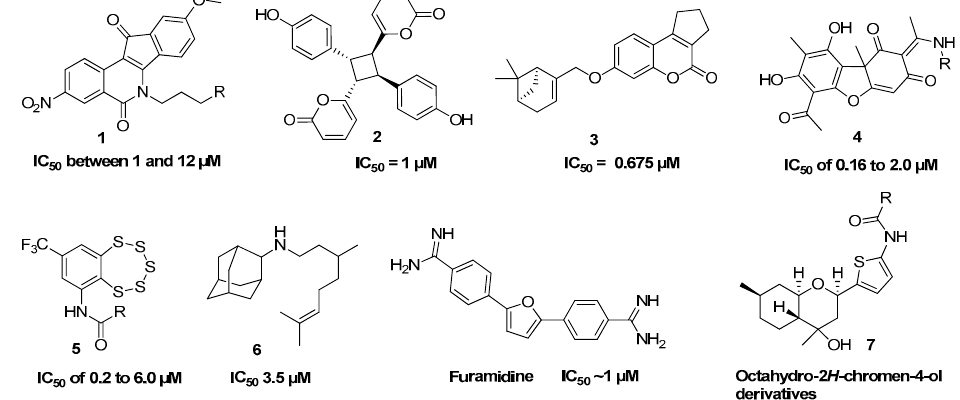
Figure 1. Structures of reported Tdp1 inhibitors 1 – 6 , commercial Tdp1 inhibitor Furamidine, and octahydro-2 H -chromen-4-ol derivatives 7 that we investigated in this study.